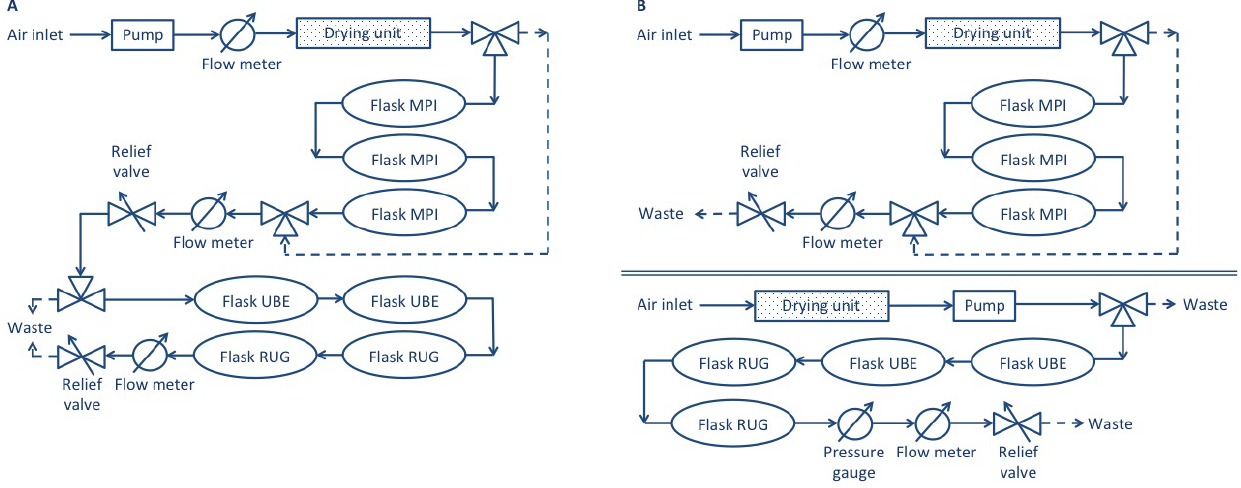
Fig. 1. Schematic diagram of the setup for flask sampling at Jungfraujoch, before March 2009 (A) and after March 2009 (B)